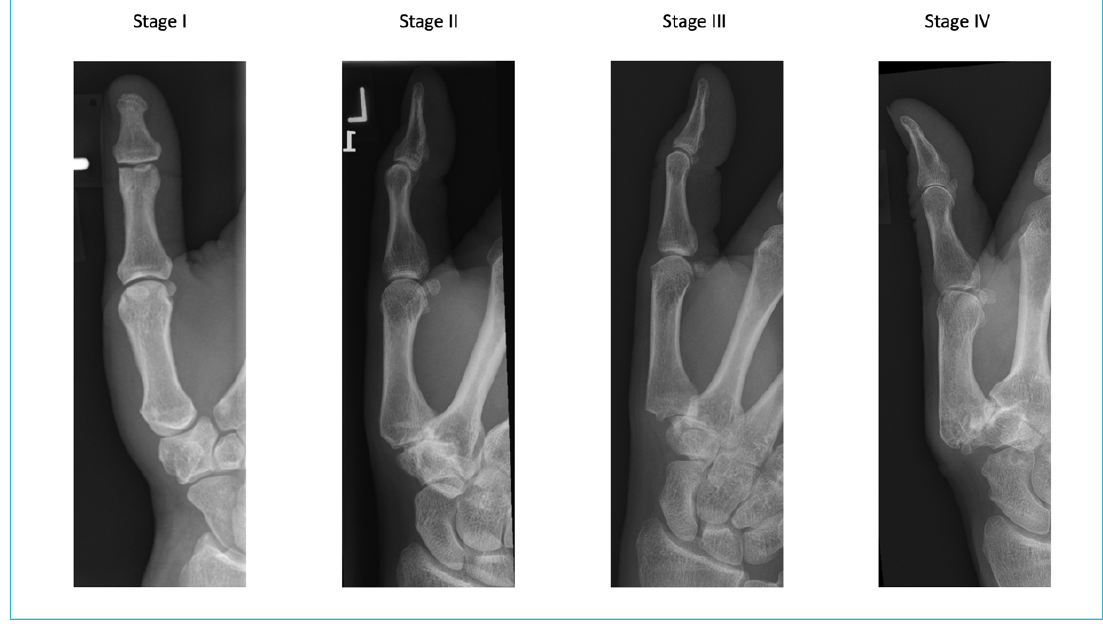
Figure 1: Eaton/Littler classification of trapeziometacarpal osteoarthritis.Stage I: slight widening of the joint space and normal contours.Stage II: slight narrowing of the TMC and sclerosis, osteophytes <2mm, up to 1/3 subluxation of the jointStage III: marked joint space narrowing, os-